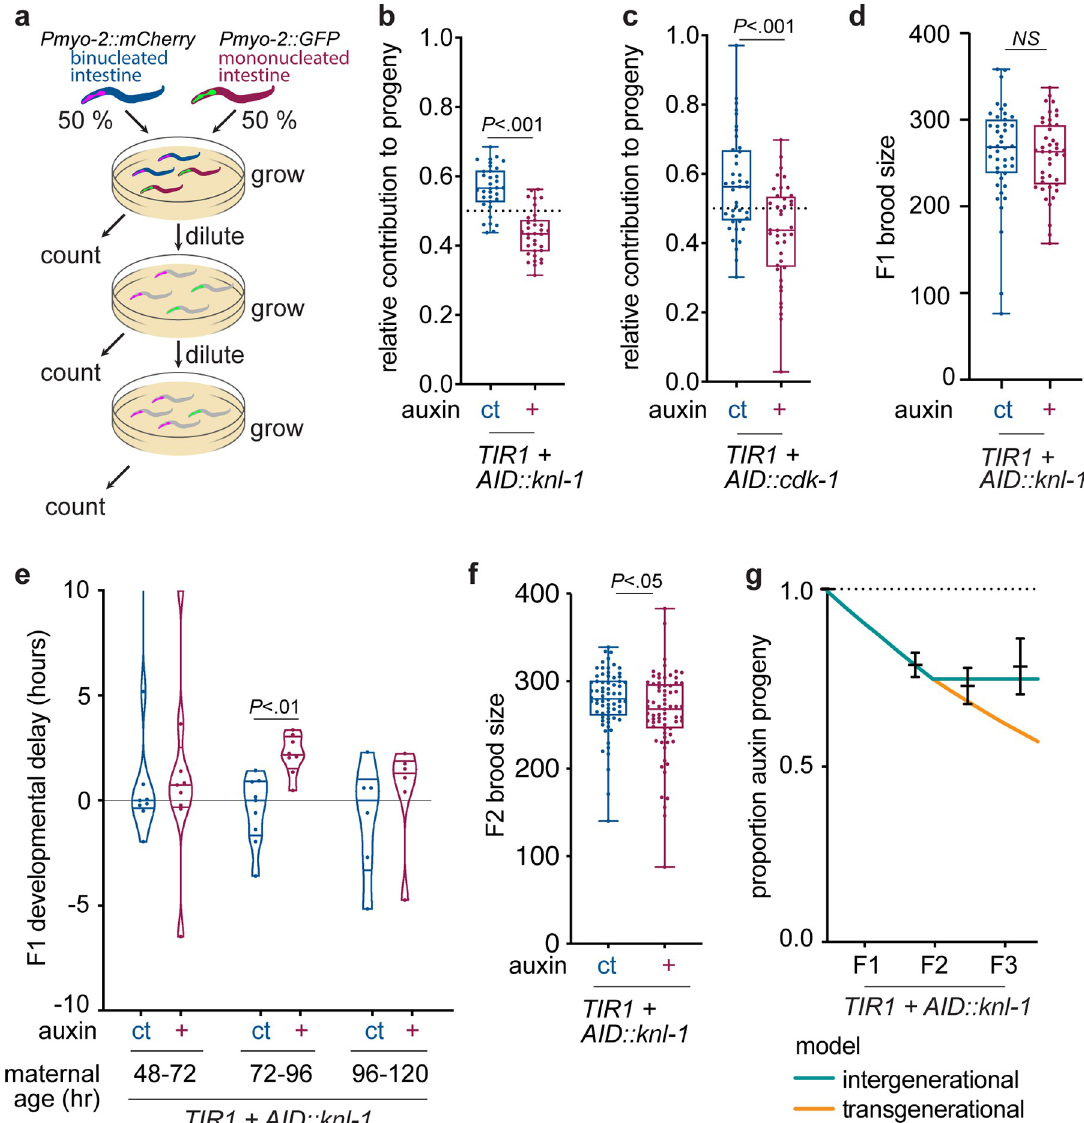
Fig 5. Inhibition of intestinal binucleation reduces relative reproductive fitness. (A) Overview of the relative fitness assay. L4 animals grown under auxin (+) or control (ct) conditions carrying a pharyngeal marker in either red ( Pmyo-2 :: mCherry ) or green ( Pmyo-2 :: GFP ) are transferred in equal amounts to a single plate. Worms are grown until the plate is full or starved, after which a random subset of worms are transferred to a new plate, effectively diluting the population, after which the proportion of mCherry + and GFP + progeny is counted. In replicate experiments, pharyngeal markers were swapped for the auxin and control conditions. Reproductive fitness measurements shown in panels B and C were made after one plate dilution, whereas reproductive fitness measured over consecutive plate dilutions is shown in panel G. (B, C) Boxplots showing the normalized proportion of progeny originating from worms with a wild- type binucleated (ct, n = 40 plates/280 worms and 34 plates/238 worms) or mononucleated (+, n = 40 plates/280 worms and 34 plates/ 238 worms) intestine in relative fitness assays using either the AID :: cdk-1 (B) or AID :: knl-1 alleles (C) to block binucleation, in 2 replicate experiments. Measurements were made after one plate dilution. Boxplots indicate the median and 25th to 75th percentile, error bars indicate min to max values, and individual values are shown as dots. (D) Boxplot showing total brood size of Pges-1 :: TIR1; AID :: knl-1 animals grown under control conditions (ct, n = 43 plates) or in the presence of auxin (+, n = 43 plates), in 3 replicate experiments. Amounts of progeny were counted for 3 days of egg laying. Boxplots indicate the median and 25th to 75th percentile, error bars indicate min to max values, and individual values are shown as dots. (E) Violin boxplots depicting progeny growth rates from worms with increasing maternal age, grown under control conditions (ct, n = 9 plates) or in the presence of auxin (+, n = 9 plates), in 3 replicate experiments. For each condition, the timing of the L3 molt was quantified (see Methods for details), and the average timing in the control condition for each maternal age was used to calculate the developmental delay. Horizontal lines indicate the median and 25th to 75th percentile, violin plots extend to min and max values and individual values are shown as dots. (F) Scatter plots of brood size in